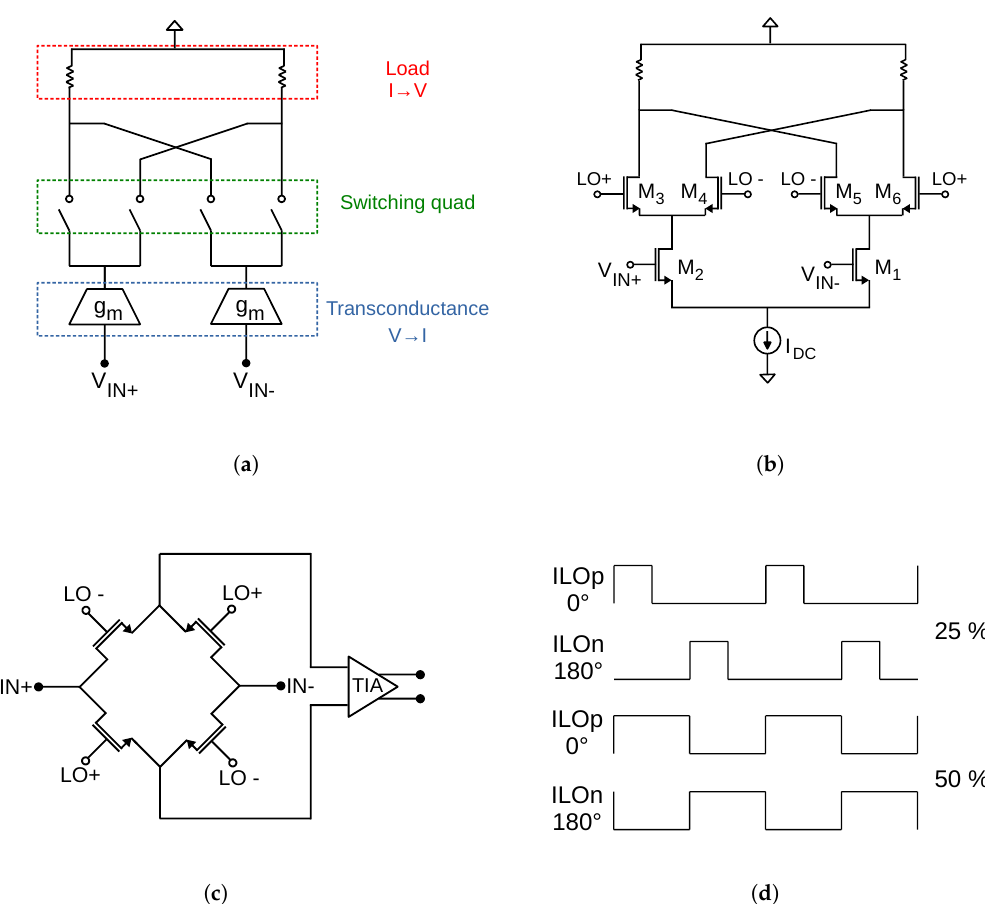
Figure 5. Schematic of a ( a ) ideal mixer, ( b ) Gilbert cell and ( c ) double-balanced passive mixer plus TIA. ( d ) Quadrature LO waveforms with 25% vs. 50% duty